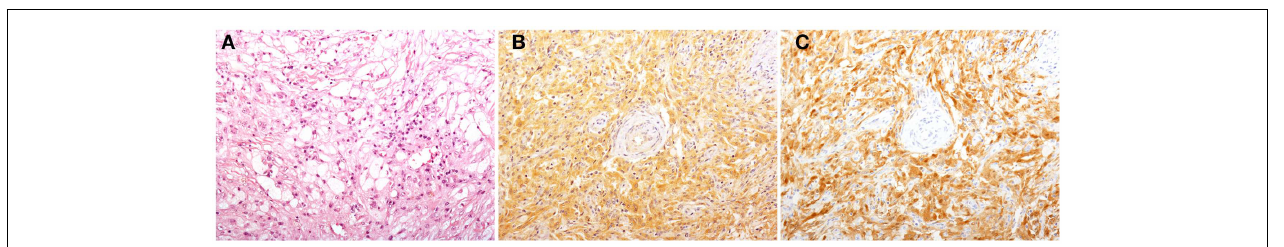
magnification 200 × ]. Immunohistochemical studies reveal that some of the infiltrating histiocytes stain for BRAF V600E [ (B) ,VE1 immunostaining, 200 × ], and p16 Ink4a [ (C) , p16 Ink4a immunostaining, 200 ×